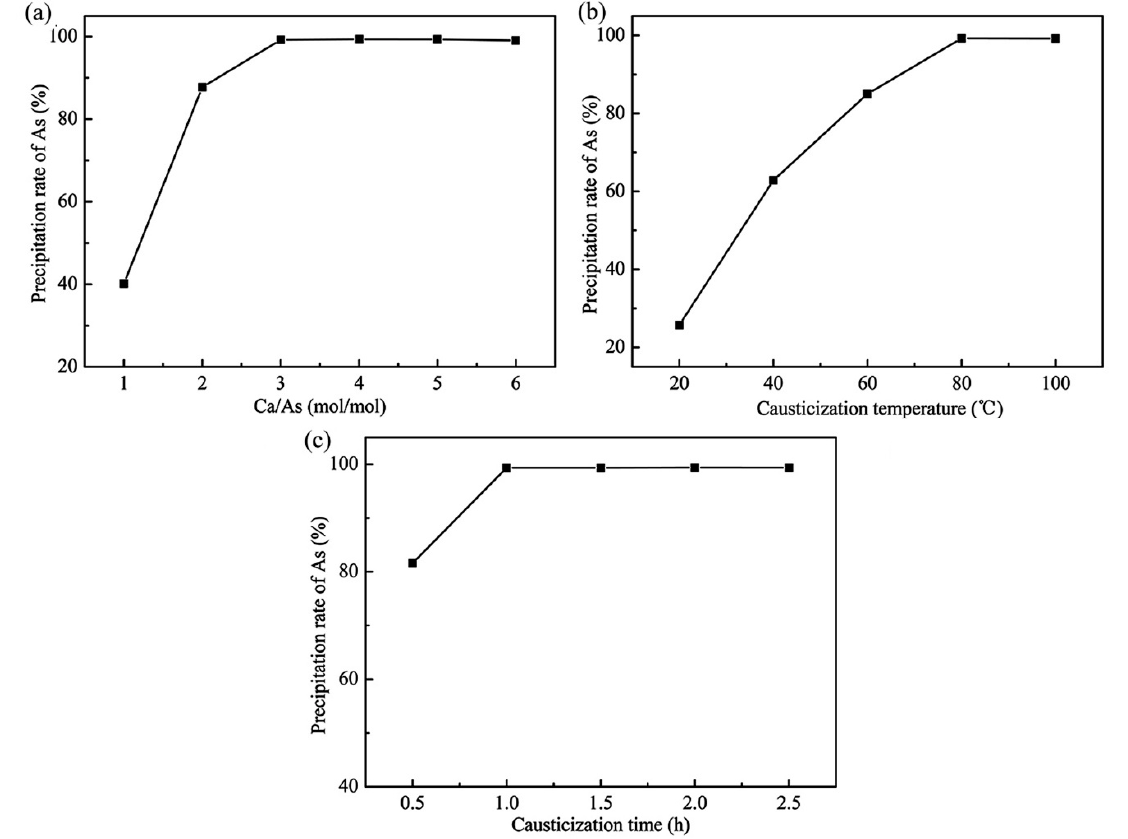
Figure 8. Effects of different causticization conditions on the precipitation rate of As: ( a ) CaO dosage (80 °C, 1.0 h), ( b ) causticization temperature (Ca/As = 4, 1.0 h), ( c ) causticization time (Ca/As = 4, 80 °C).